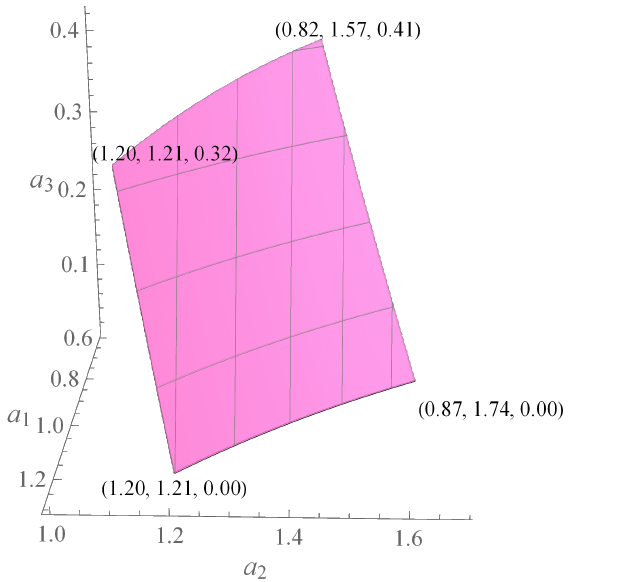
Figure 6. “Viable” region of Kähler moduli space that satisfies all phenomenological and mathe- matical constraints for the line bundle L = O